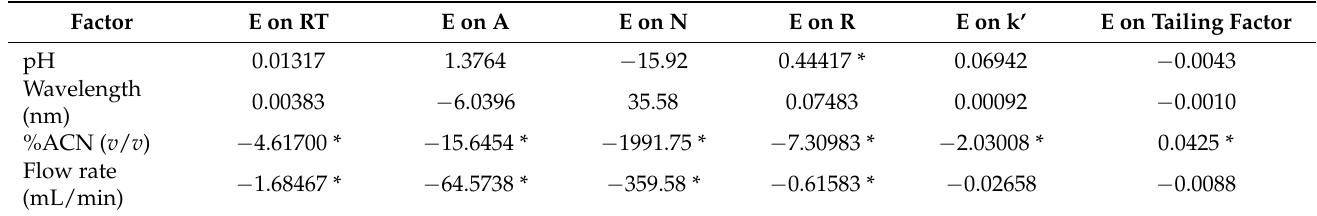
Table 6. Obtained simple effect (E) of a given factor on each of the monitored